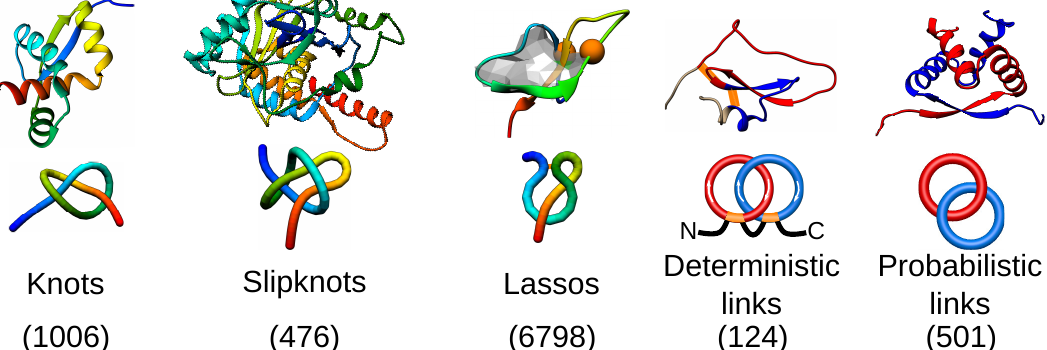
Figure 1. Types of entanglement identified up to now in proteins, represented by the simplest topological motif. From left to right: the trefoil knot (PDB ID 1j85), the trefoil slipknot (PDB ID 1hyn), the single lasso (a covalent loop is pierced once by a tail; PDB ID 1ews), the deterministic (PDB ID 2lfk) and probabilistic (PDB ID 1arr) Hopf link. For each topological group, the exemplary protein structure along with a scheme of the topology is presented. The numbers present the current number of identified structures with a given topological motif based on the databases: KnotProt, LassoProt and